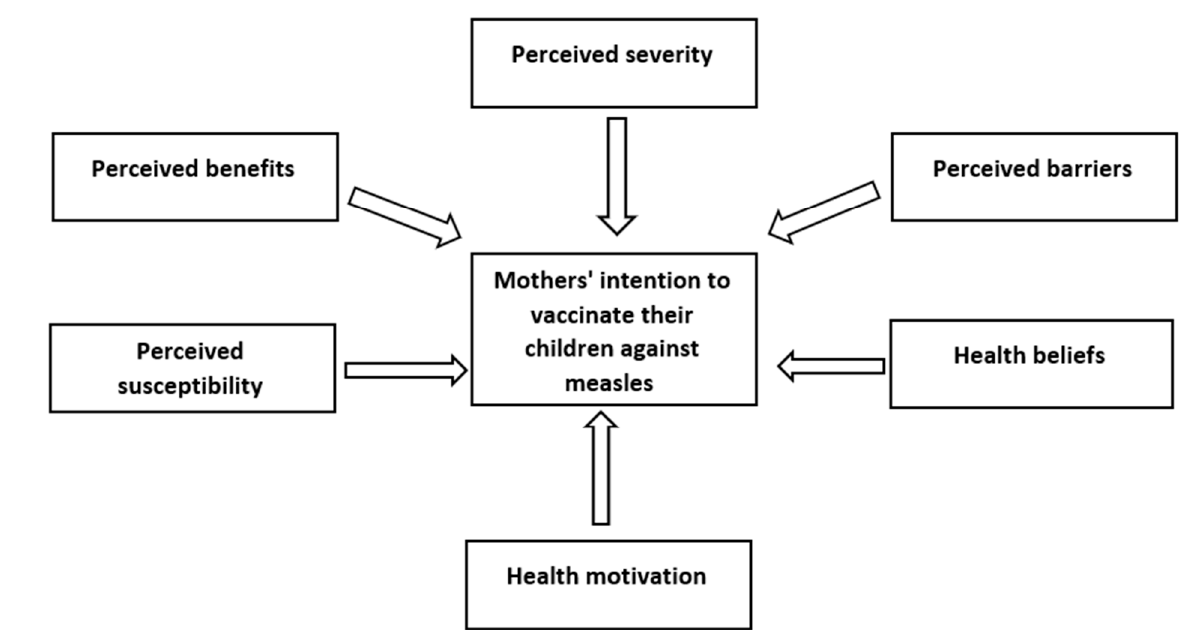
Figure 1. Research